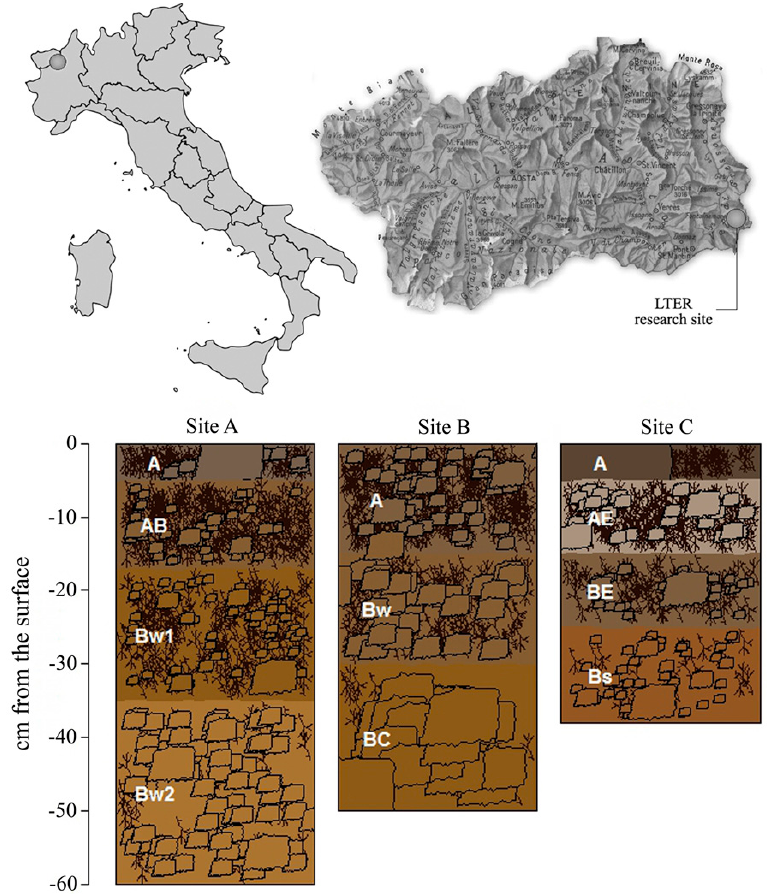
Figure 1. On the top, the location of the research area (LTER Mt. Mars, LTER_EU_IT_075) in the Valle d’Aosta Region (northwest (NW) Italy), and on the bottom the soil profiles described according to the Food and Agriculture Organization FAO Guideline for soil description (2006) and classified according to the Internationat Union of Soil Sciences-IUSS Working Group WRB (2015) as Skeletic Dystric Cambisol (Humic) (sites A and B ), and Skeletic Albic Podzol (site C ). Soil profiles were drawn employing the “soilprofile” package of R Studio software (R Development Core Team, 2010).